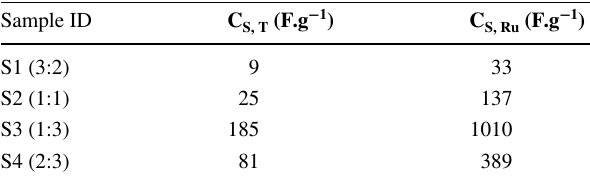
Fig. 6 A) : The charge discharge curves of SnO 2 -RuO 2 mixed films for samples (a) S1 (SnO 2 :RuO 2 , 3:2), (b) S2 (1:1), (c) S3 (1:3) and (d) S4 (2:3) in the potential window of − 0.2 to 0.6 V vs. SCE at the cur- rent density of 1 mA cm −2 in 0.5 M H 2 SO 4 . B) The Ragone plot for Fig. 5 The cyclic voltammograms of SnO 2 -RuO 2 mixed films for samples (a) pure SnO 2 , (b) S1 (SnO 2 :RuO 2 , 3:2), (c) S2 (1:1), (d) S3 (1:3) and (e) S4 (2:3) in the potential range of -0.2 to 0.6 V vs. SCE at the 5 mV.s −1 in 0.5 M H 2 SO 4 Table 3 Effects of composition on the total specific capacitance (C S,T ) and specific capacitance based on RuO 2 (C S,Ru ) for SnO 2 com- bined with RuO 2 electrodes